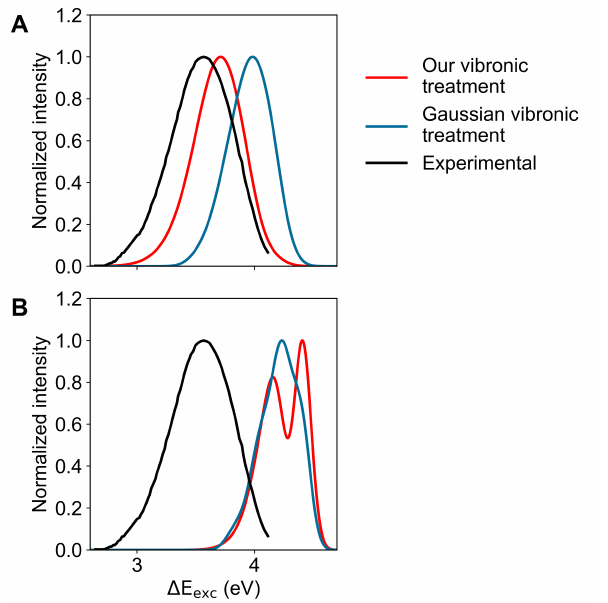
Figure 8. Calculated (coloured) and measured (black; adapted from Hilaire et al. [53]) normalized emission spectra of indole in aqueous solution. Spectra calculated using our vibronic treatment are reported in red, while the spectra obtained by the vibronic structure calculated using the algorithms implemented in Gaussian are reported in blue. ( A ): Spectra calculated in the L a -state MD ensemble. ( B ): Spectra calculated in the L b -state MD